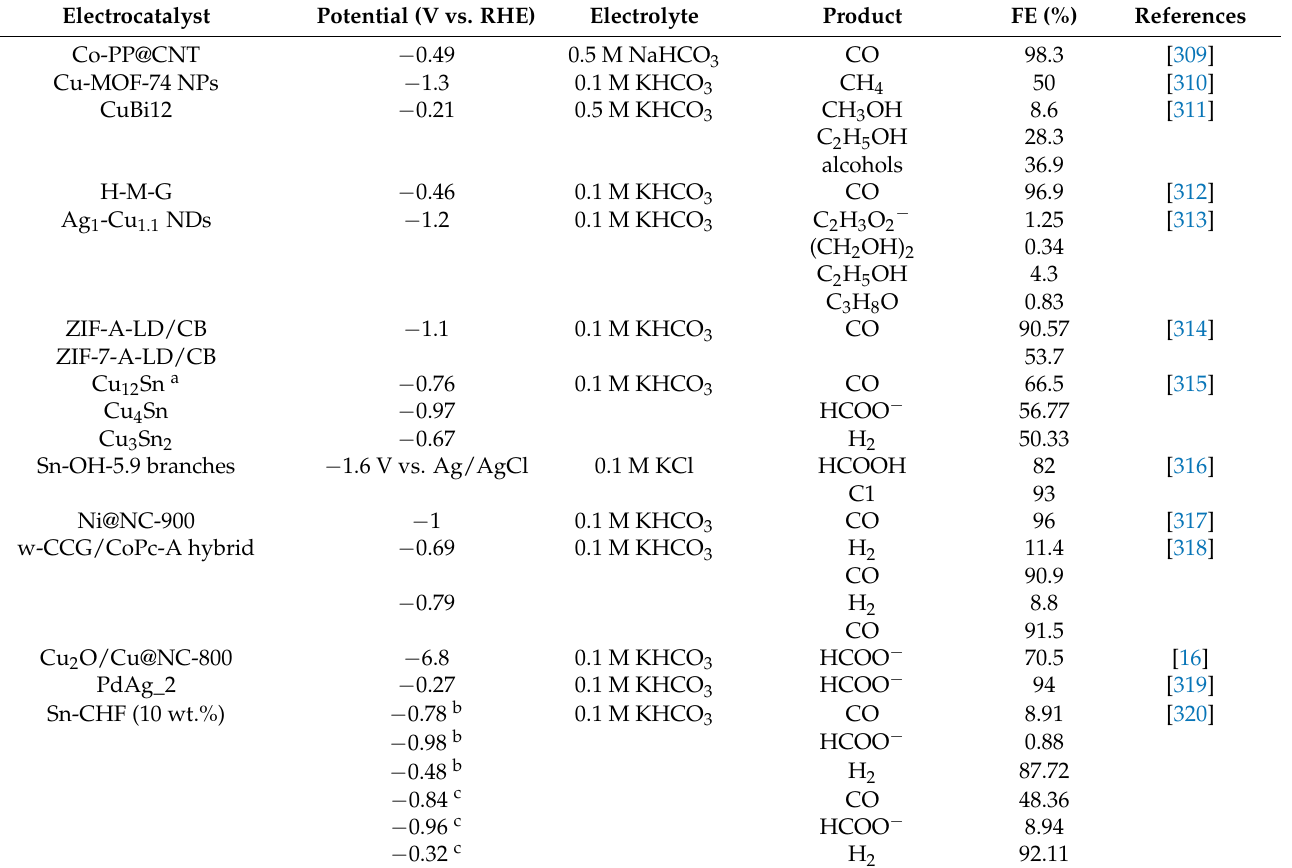
Table 7. Summary of the recently studied electrocatalysts for CO 2 reduction